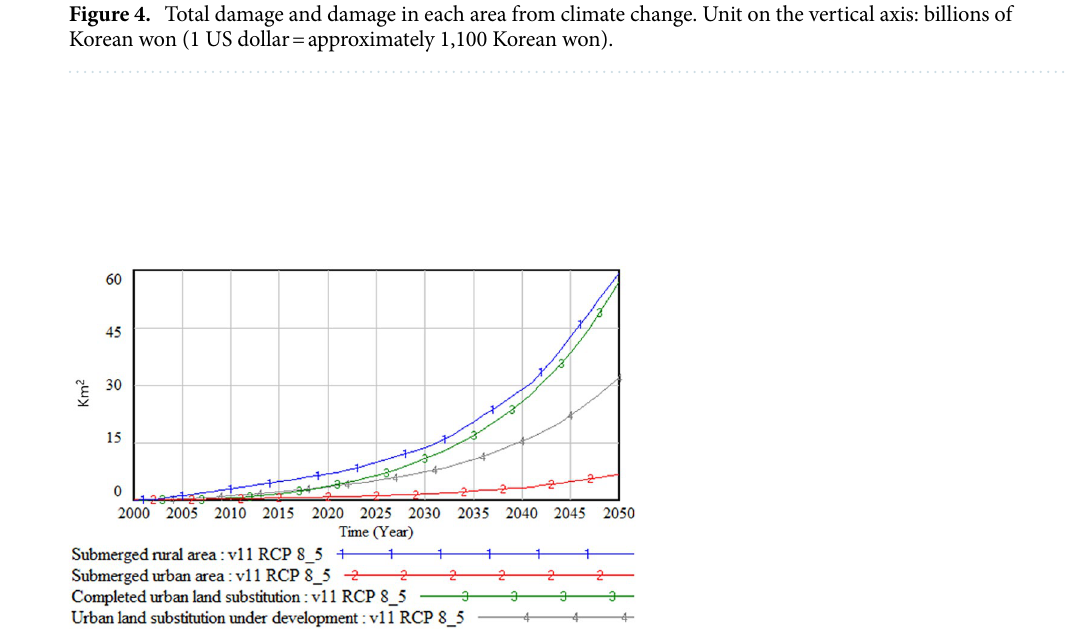
Figure 5. Damaged urban and rural